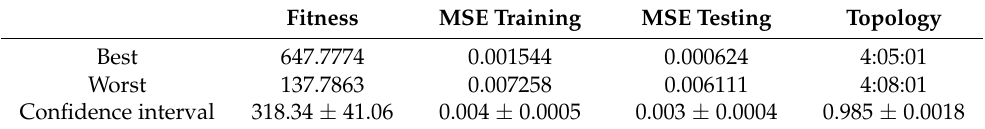
Table 4. Statistic indicators for 50 runs for the ANN-GWO approach.